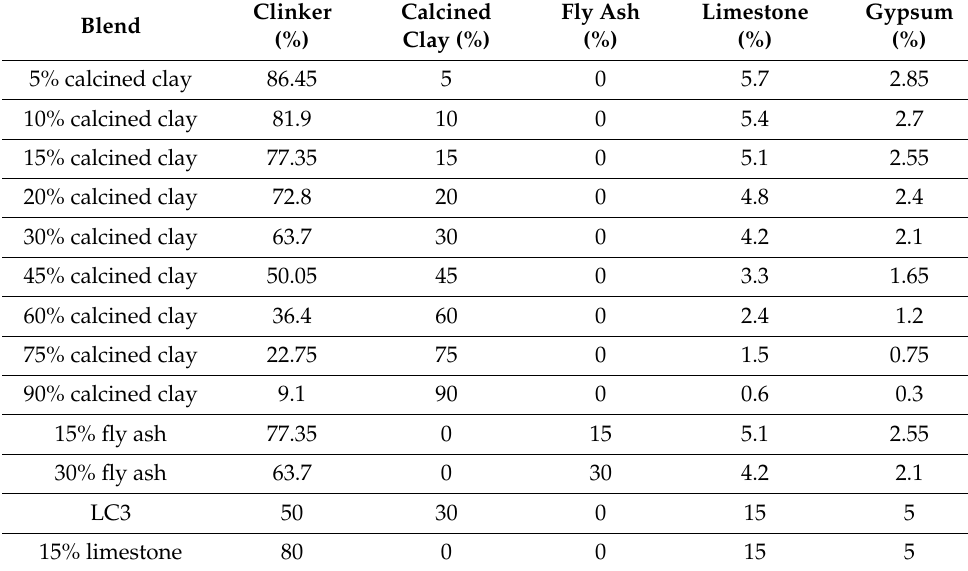
Table 1. SCM–OPC blends used in this